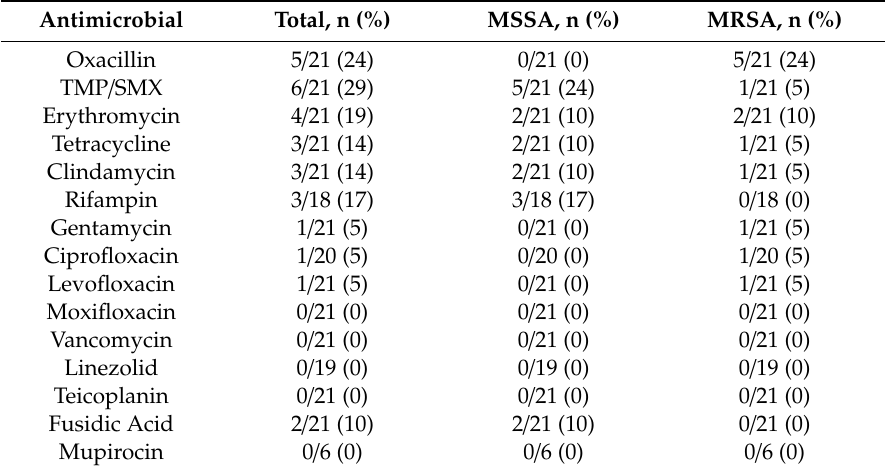
Table 2. Antimicrobial resistances of PVL-SA isolates. Antimicrobial Total, n (%)